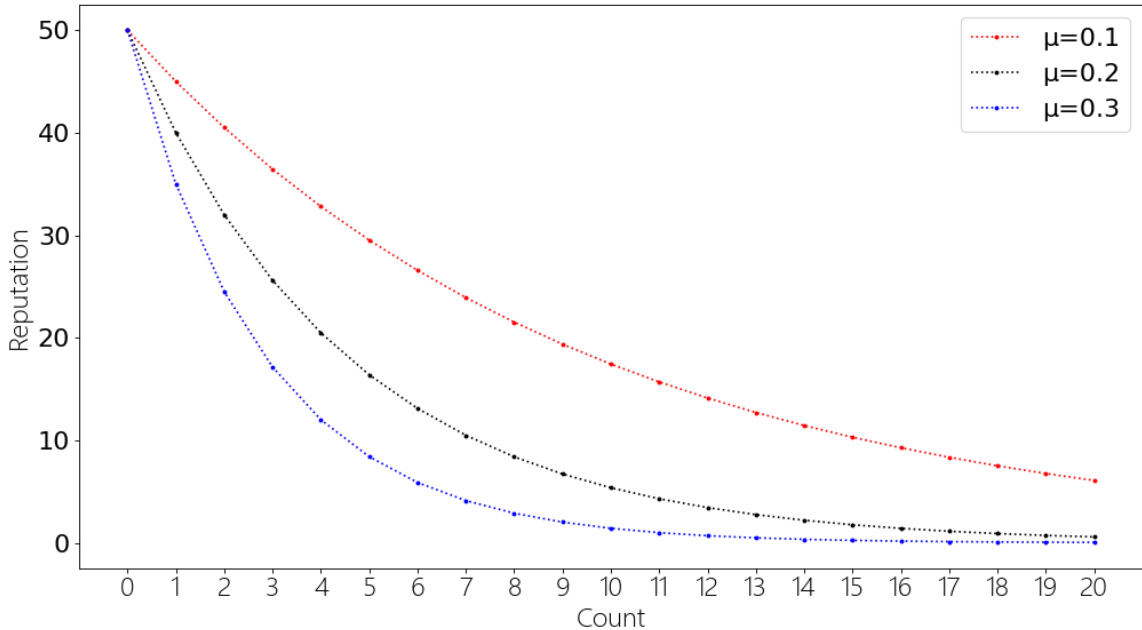
Figure 8. The decrease in reputation under different μ .